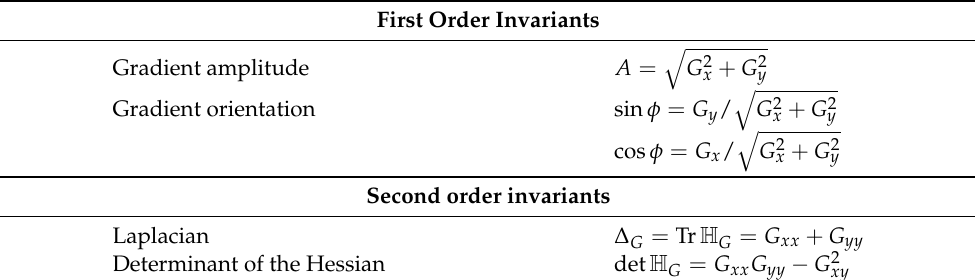
Table 1. Low-order differential